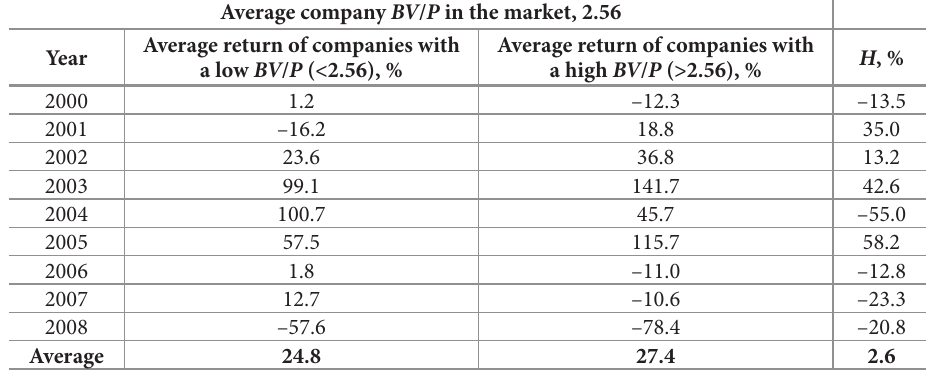
Table 2. Average company BV / P in the market on 31/12/2008 Average company BV / P in the market, 2.56